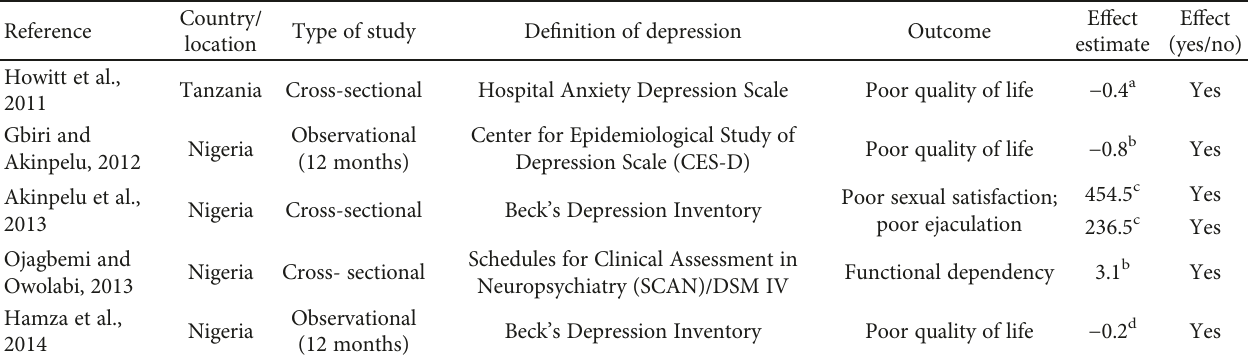
Table 3: Outcome of poststroke depression in sub-Saharan Africa.